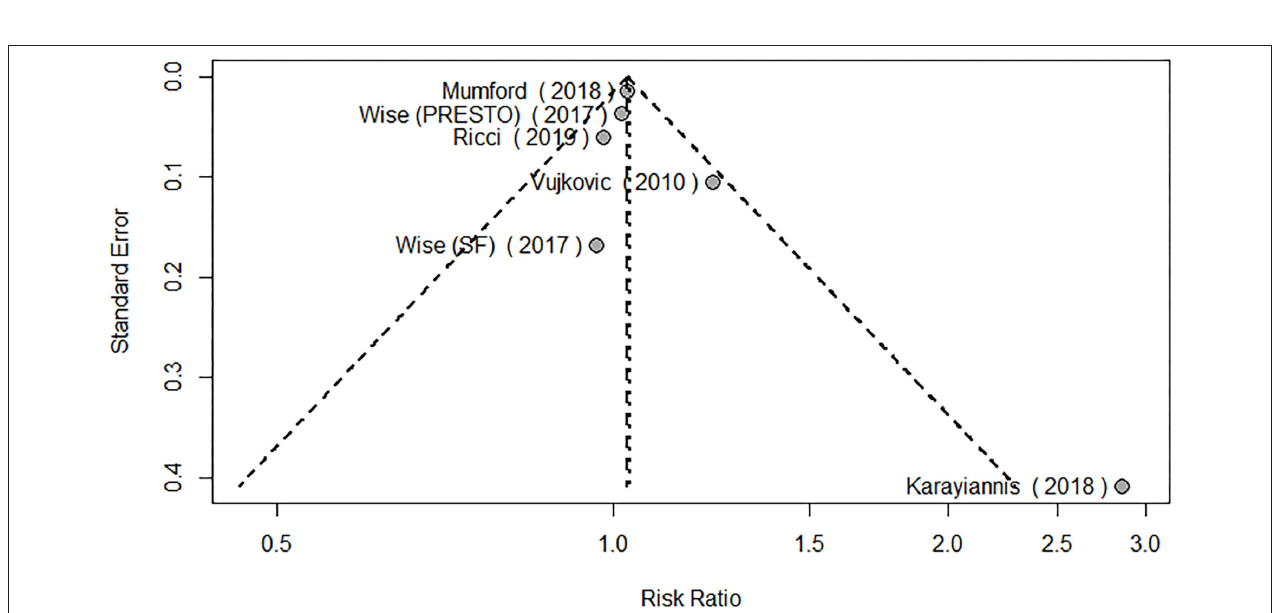
FIGURE 6 | Forest plot for the meta-analysis of the relationship between periconceptional intake of MUFAs and pregnancy achievement ( n = 2,473).